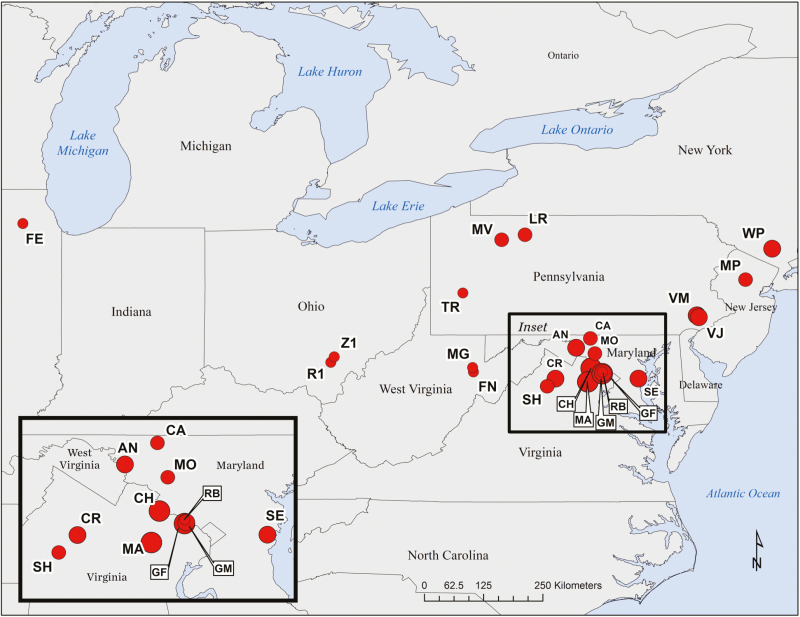
Locations of 23 deer research sites in east-central and north-eastern USA included in pooled analyses. Symbol size indicates sampling intensity across sites, which are labelled with two-letter codes (see Table 1 for additional site information).